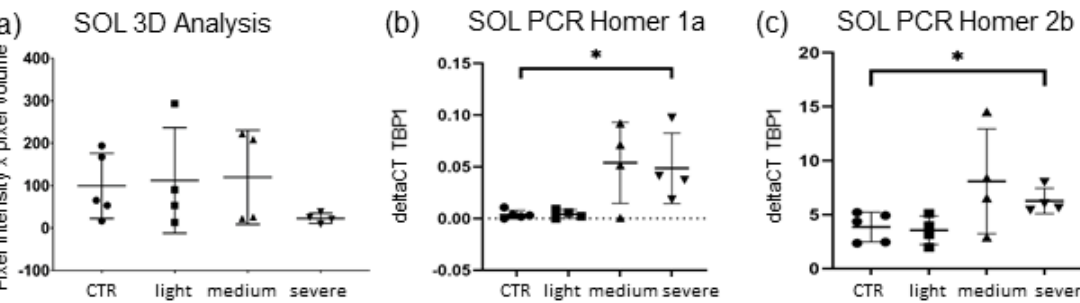
Figure 4. Homer protein isoform expression in SOL and EDL muscle. ( a ): 3D-analysis of endplate Homer pixel intensity and volume. A trend of reduction can be seen in severely affected EAMG mice in Homer quantity compared to CTR (−37%, p ≤ 0.111). ( b , c ): By qPCR-analysis, a significant increase of mRNA was detected in SOL -muscle for short isoform 1a (+932%, p ≤ 0.021) and long isoform Homer 2 (+62%, p ≤ 0.027). Homer 2b increase is lower than 1a-increase. Both times mRNA elevation was attested in severely affected mice, in medium affected mice only a trend was observed. Data are normalised to TATA-box-binding protein (TBP1) and expressed as means ± SD. Mann–Whitney-U test, significance level p ≤ 0.05. * indicates significant difference vs. CTR.